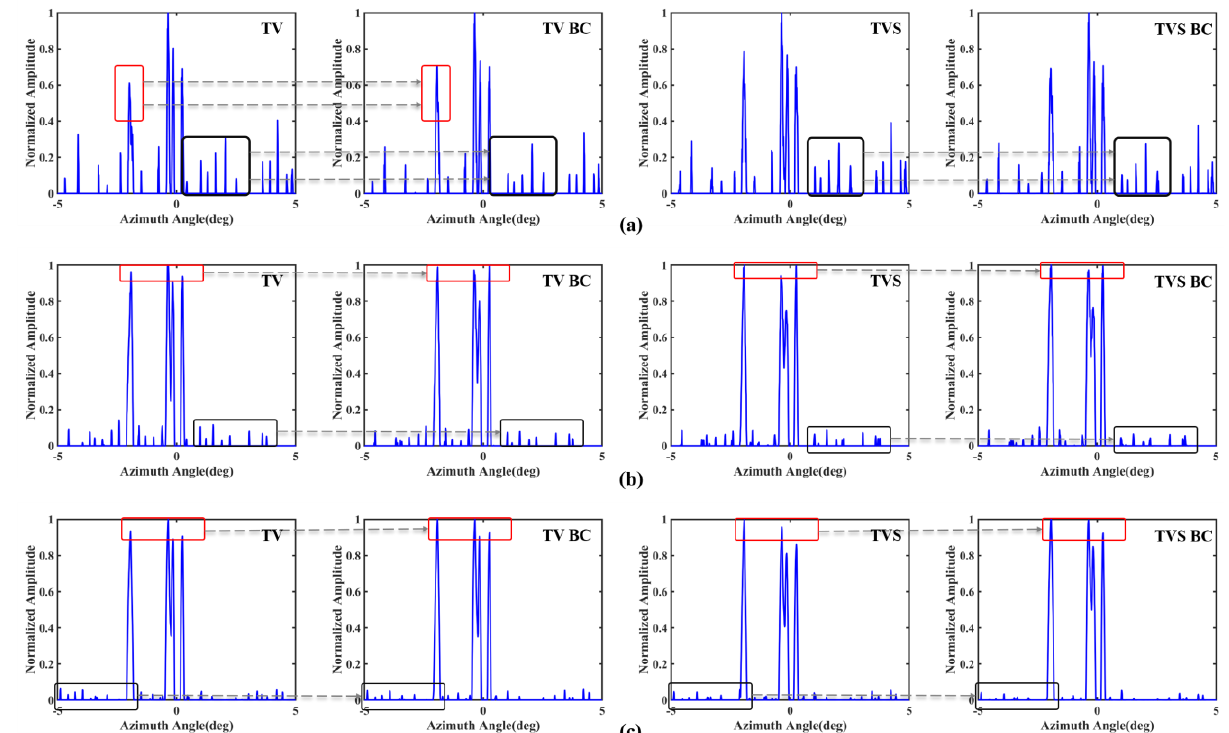
Figure 7. Restoration results for experimental scenes with noise of difference simulated SNRs. ( a ) SNR = 5 dB, ( b ) SNR = 13 dB, ( c ) SNR = 21 dB.